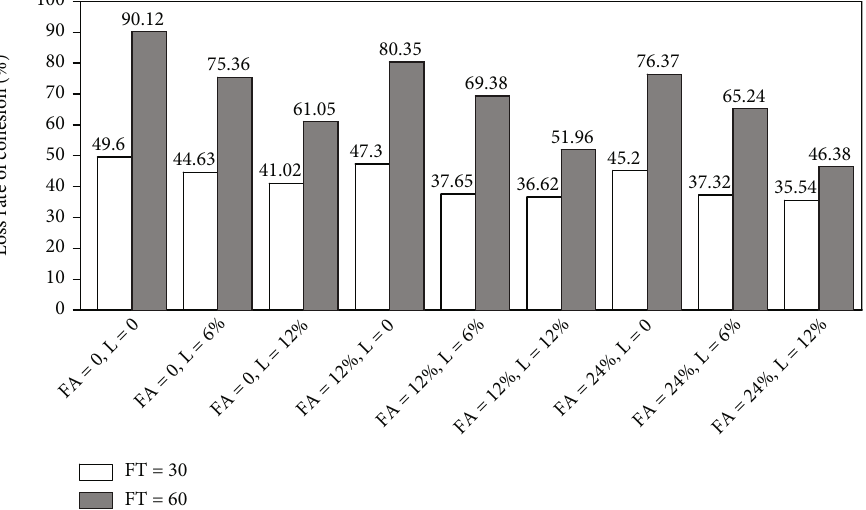
Figure 29: Loss rate of cohesion after freeze-thaw